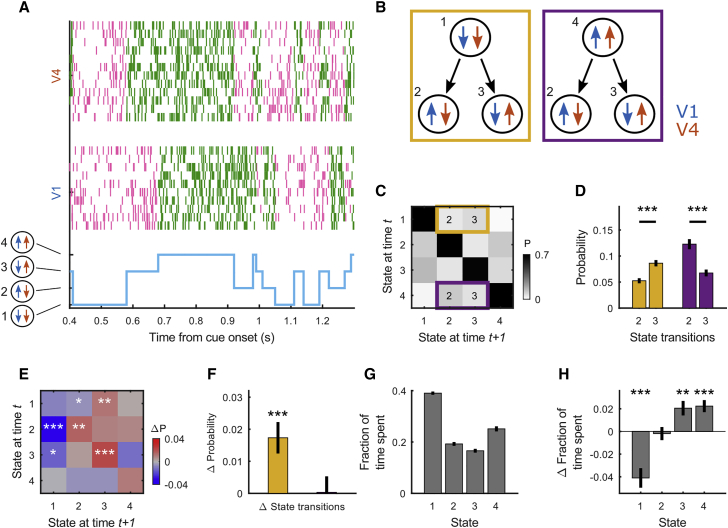
HMM with 4 states fit simultaneously to V1 and V4 data(A) Example trial with the HMM state-trajectory (bottom) and across-laminar MUA raster plot for V1 (center) and V4 (top).(B) Schematic describing scenarios for testing 2 questions: (1, left yellow box) from a state in which both V1 and V4 are Off, is it more likely for V1 or V4 to transition to the On phase first? (2, right purple box) From a state in which both V1 and V4 are On, is it more likely for V1 or V4 to transition to the Off phase first?(C) HMM transition probability matrix, indicating the probability of staying in a state (diagonal) or transitioning from one state to another. Highlighted are scenarios set out in (B).(D) Transition probabilities indicated in (B) and (C).(E) Attentional influence on state-transition probabilities: the difference transition matrix (attend RF–attend away) is shown.(F) Attentional influence (attend RF–attend away) on the difference between state transition probabilities (state 3–state 2) for each of the 2 scenarios indicated in (B)–(D). Selective attention increases the difference between the transition probabilities for states 2 and 3 for the yellow, but not the purple scenario.(G) The fraction of time spent in each of the 4 states.(H) The difference in time spent in each of the 4 states when attention is directed toward or away from the RF (attend RF–attend away).Statistics: two-sided Wilcoxon signed rank test (FDR corrected); data are represented as means ± SEMs across recordings; significance levels ∗p < 0.05, ∗∗p < 0.01, and ∗∗∗p < 0.001.